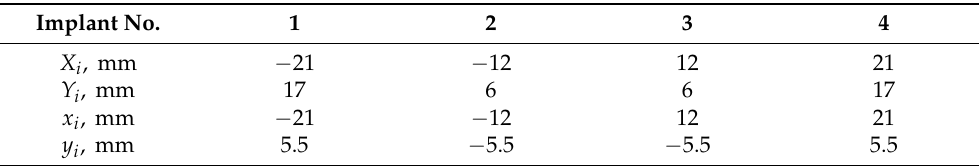
lines in Table 2. Table 1. Coordinates of implants in the original and central coordinate system (the first variant of Table 1. Coordinates of implants in the original and central coordinate system (the first variant of Table 1. Coordinates of implants in the original and central coordinate system (the first variant of Table 1. Coordinates of implants in the original and central coordinate system (the first variant of Table 1. Coordinates of implants in the original and central coordinate system (the first variant of Table 1. Coordinates of implants in the original and central coordinate system (the first variant of Table 1. Coordinates of implants in the original and central coordinate system (the first variant of Table 1. Coordinates of implants in the original and central coordinate system (the first variant of implant placement). implant placement). implant placement). implant placement). implant placement). implant placement). implant placement). implant placement). Table 1. Coordinates of implants in the original and central coordinate system (the first variant of implant placement).